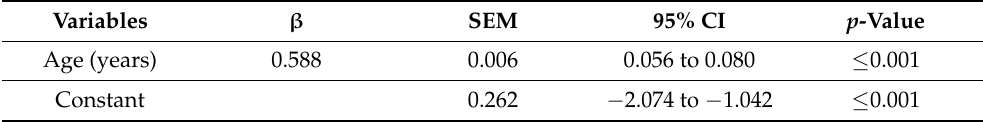
Table 7. Hearing loss in a multiple regression analysis.